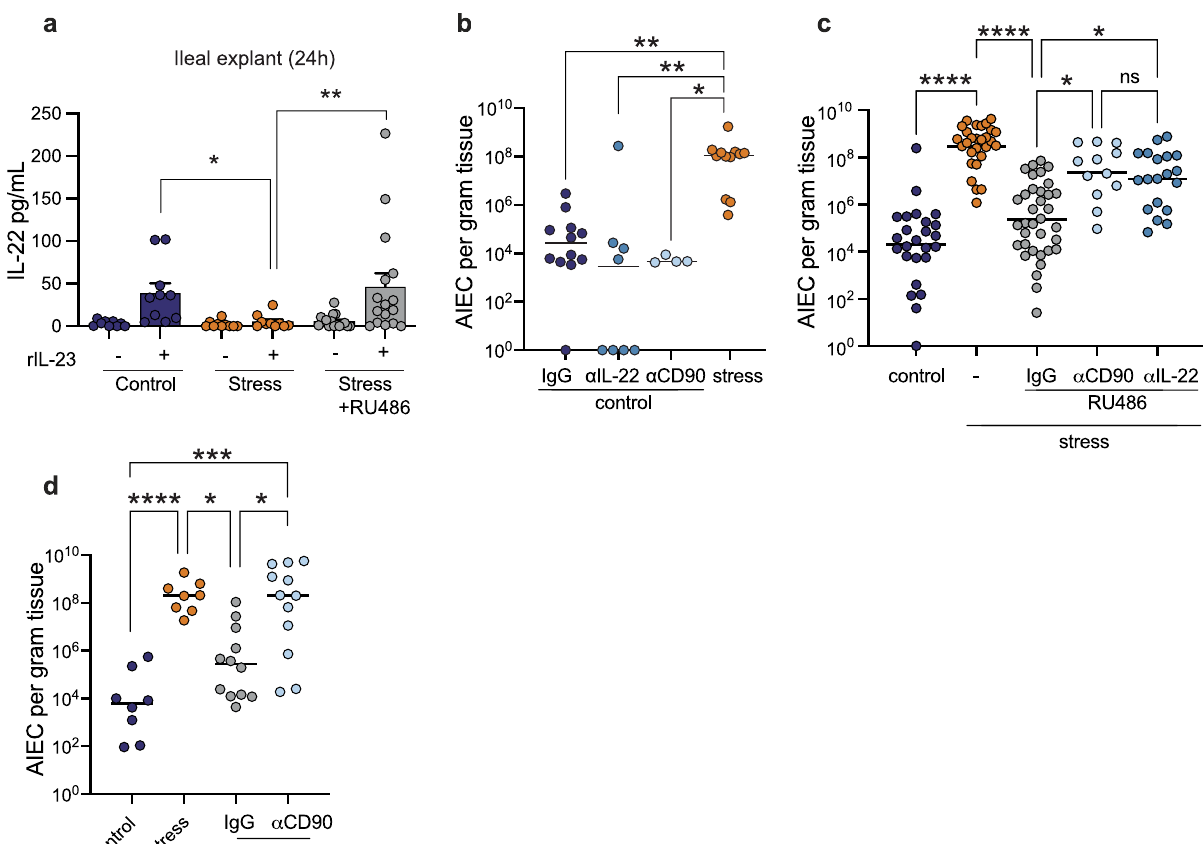
Fig. 6 Combinatorial effects of nutritional immunity and immune depletion are responsible for intestinal dysbiosis. a Quanti fi cation of IL-22 in the supernatants of ileal explants from starved ( n = 10), stressed ( n = 10), RU486 treated stress ( n = 16) mice stimulated with 20ng/mL rIL-23 or media control for 24h. Signi fi cance was determined by one-way ANOVA, not corrected for multiple comparisons, control:stress p = 0.0285, stress:stress RU486, p = 0.0033. b Ileal AIEC tissue burdens from control ( n = 12), α IL-22 ( n = 8), α CD90 treated ( n = 4), and stress ( n = 12) mice. Signi fi cance was determined by one-way ANOVA, not corrected for multiple comparisons, control:stress, p = 0.0063; control α IL-22: stress, p = 0.0013; control α CD90:stress, p = 0.0106. c Ileal AIEC tissue burdens from control ( n = 19), stress ( n = 22), RU486 treated stress (n = 25), RU486 and α CD90 treated stress ( n = 12), and RU486 and α IL-22 treated stress ( n = 13). Signi fi cance was determined by one-way ANOVA, not corrected for multiple comparisons, control:stress, p < 0.0001; stress:stress + RU486 IgG, p <0.0001; stress + RU486 IgG:stress + RU486 α CD90 p = 0.0284; stress + RU486 IgG:stress + RU486 α IL-22, p = 0.0301. d Ileal AIEC tissue burden in control ( n = 24), stress ( n = 18), LPS treated ( n = 22), and LPS and α CD90 treated ( n = 12) mice. Signi fi cance was determined by one-way ANOVA, not corrected for multiple comparisons, control:stress, p = 0.0006; control:LPS + α CD90, p = 0.0003; stress:LPS, p = 0.0399; LPS:LPS + α CD90, p = 0.0357. (* p ≤ 0.05; ** p ≤ 0.01; *** p ≤ 0.001; **** p ≤ 0.0001). Error bars represent SEM and the line in CFU graphs indicates the geometric mean of the